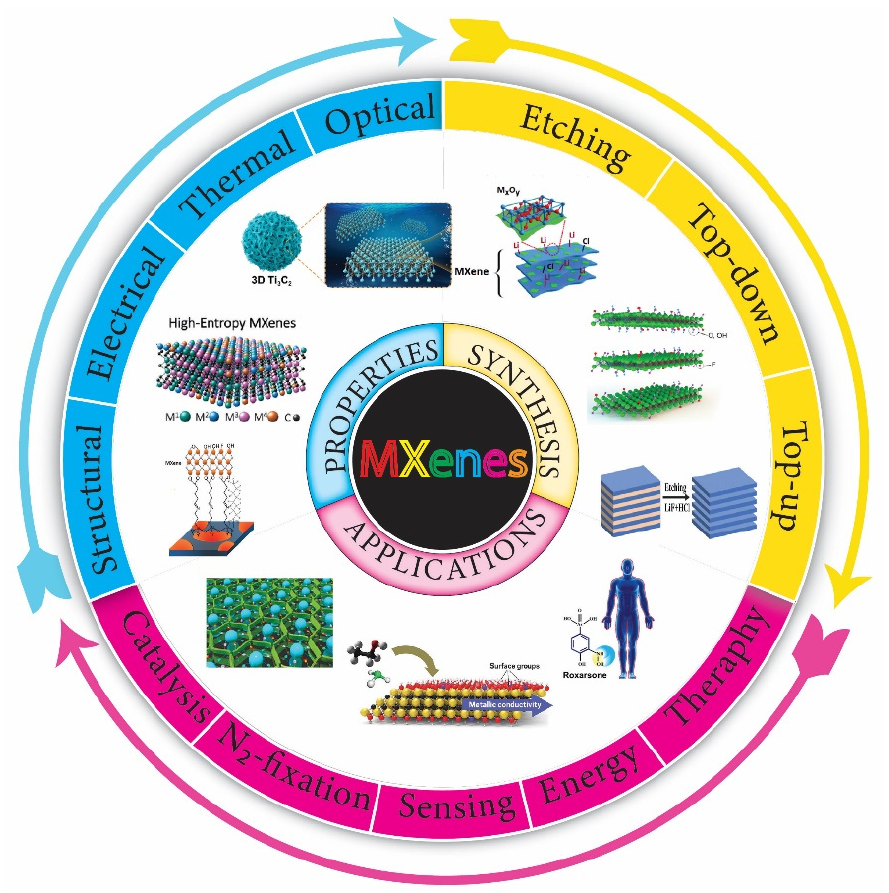
Figure 1. Scheme for the synthesis, properties, and applications of MXenes.